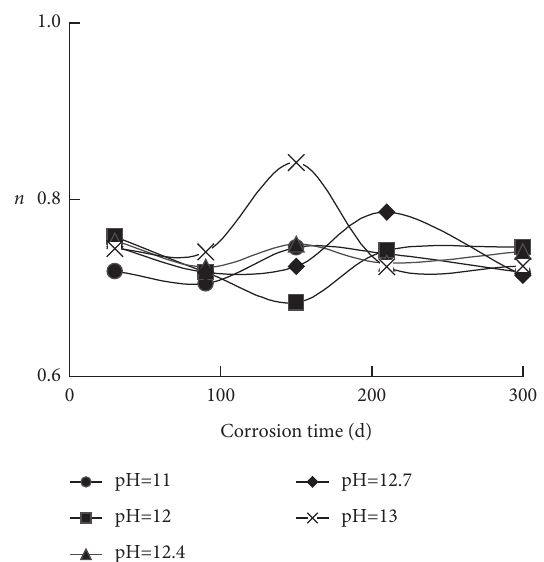
Figure 5: Variation pattern of the parameter n with the permeation time at different alkaline-solution concentrations.